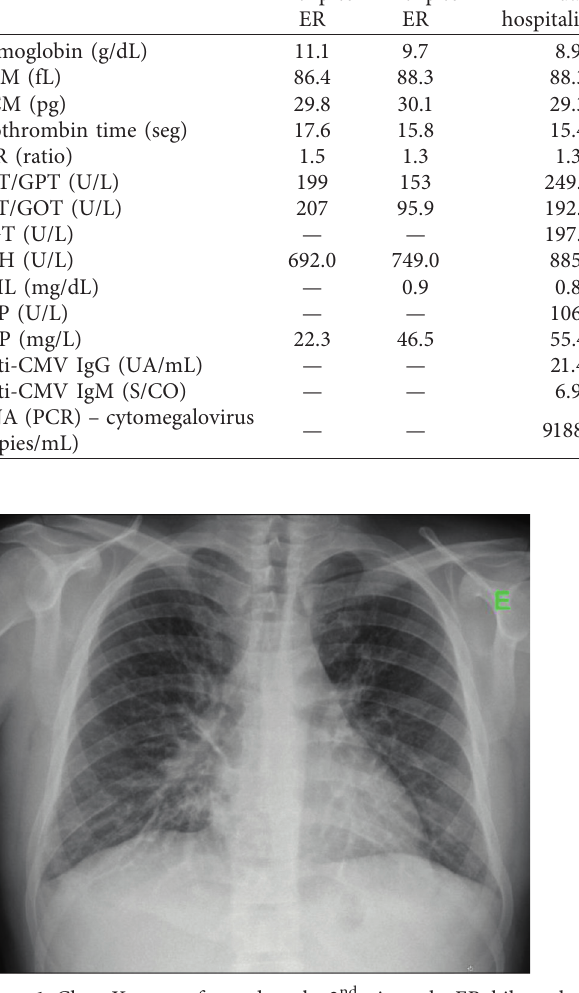
Table 1: Analytical evolution from the 1 st visit to ER up to 8 days of therapy with valganciclovir. 1 st trip to